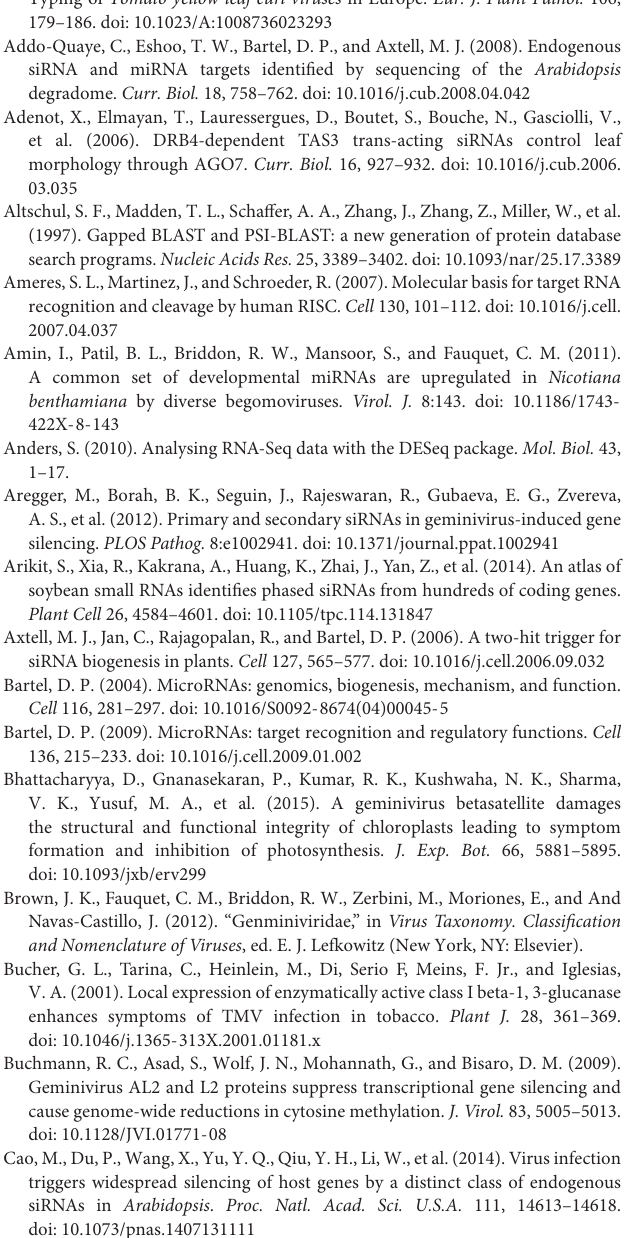
TABLE S1 | Statistics of Solanum lycopersicum genomic and non-genomic siRNAs in tomato yellow leaf curl sardinia virus-infected and mock-inoculated plant tissues. TABLE S2 | Diversity of selected functional conserved miRNAs (expression profile in sRNA datasets from mock-inoculated and TYLCSV-infected tomato plants). Bold characters indicate nucleotides differing from the canonical miRNA sequence. TABLE S3 | In silico analysis of miRNA targets among the selected gene families, validated by PARE analysis.